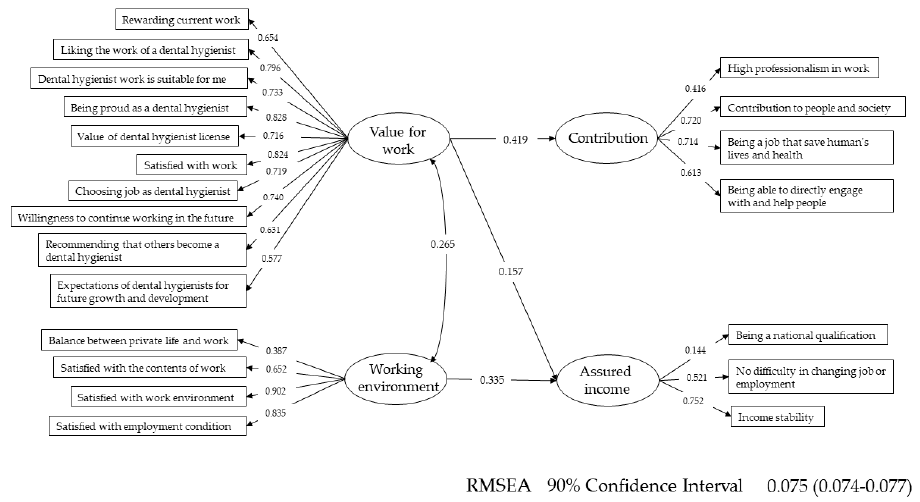
Figure 3. Path diagram of job satisfaction and attractiveness of dental hygienists’ work; RMSEA: Root Mean Square Error of Approximation.